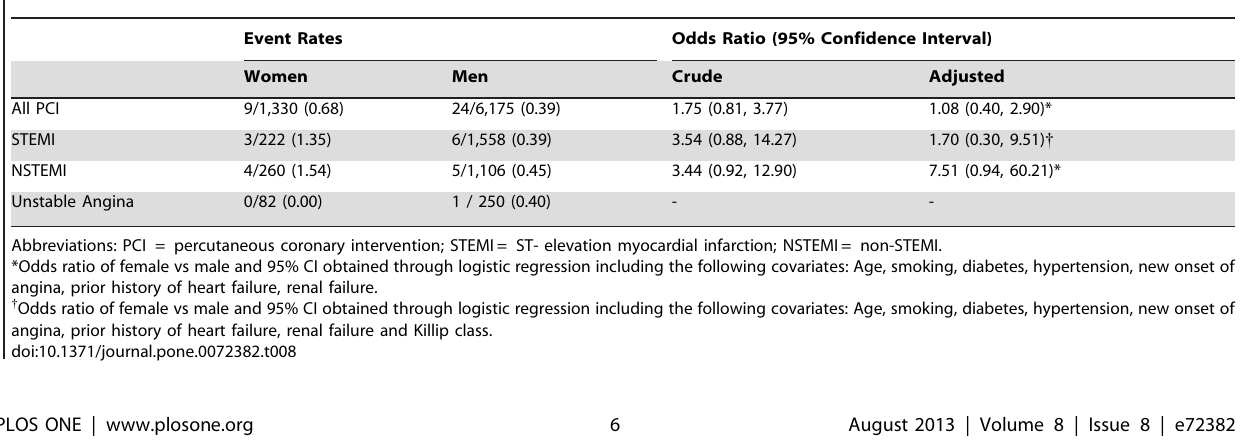
Table 8. Risk of mortality at 30 days for women compared to men.